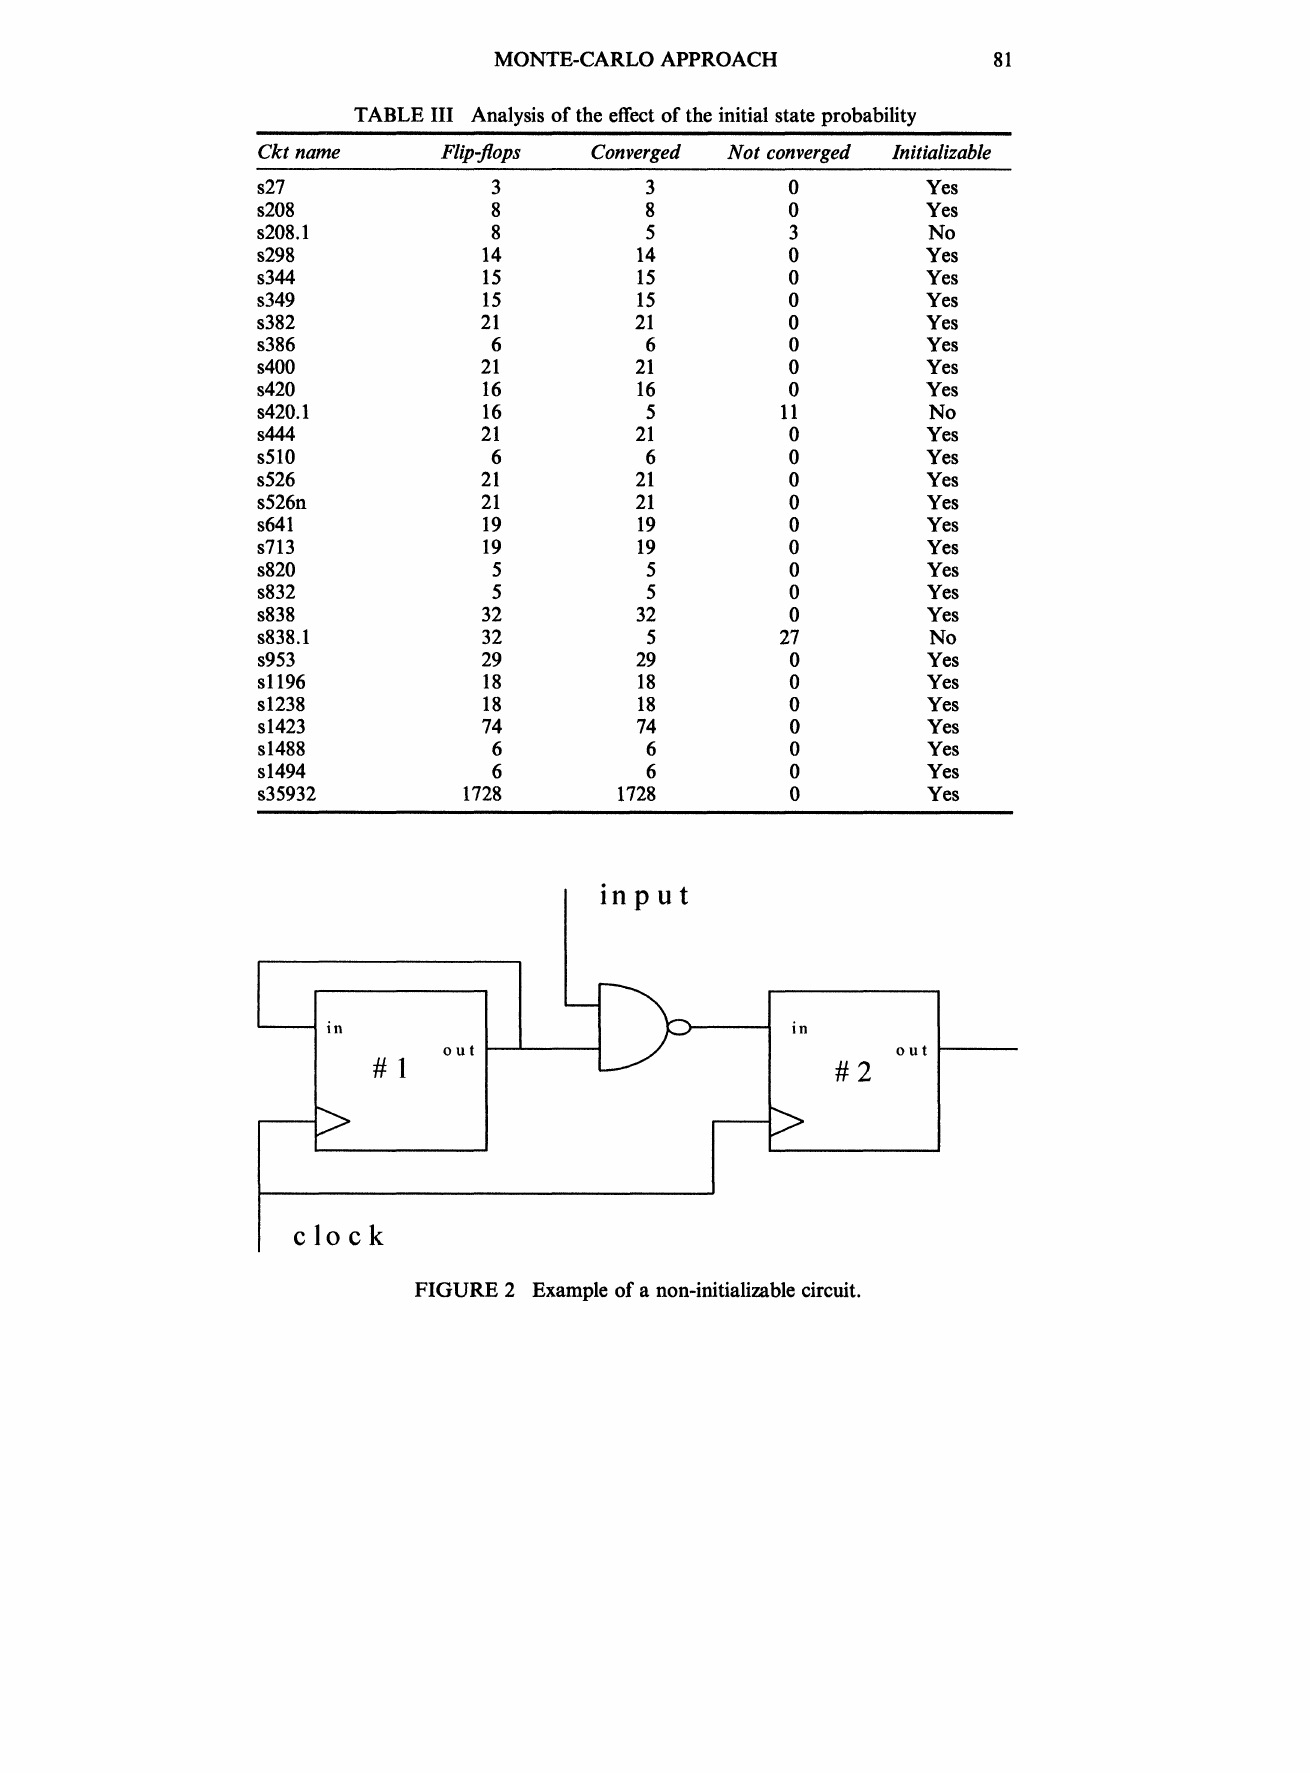
FIGURE 2 Example of a non-initializable